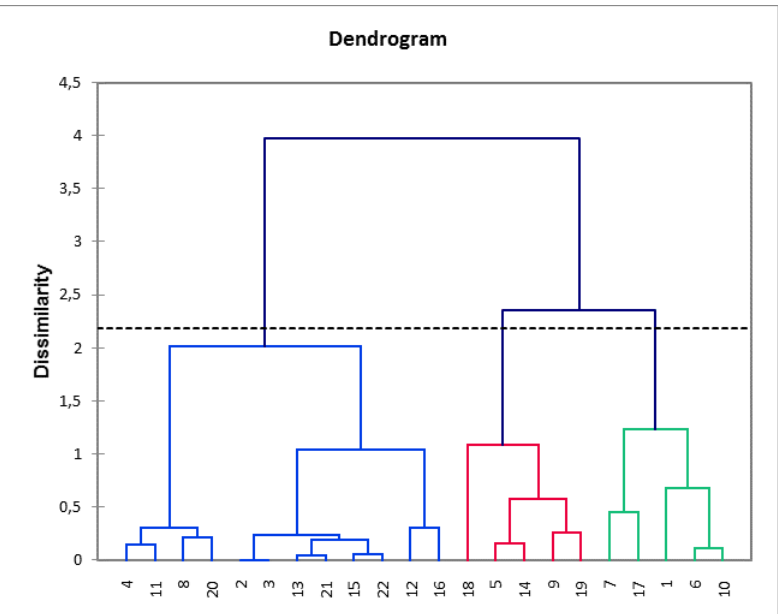
Figure 4. Dendrogram plot generated from the hierarchical cluster analysis of alert behaviors of the population study: Clusters distribution.